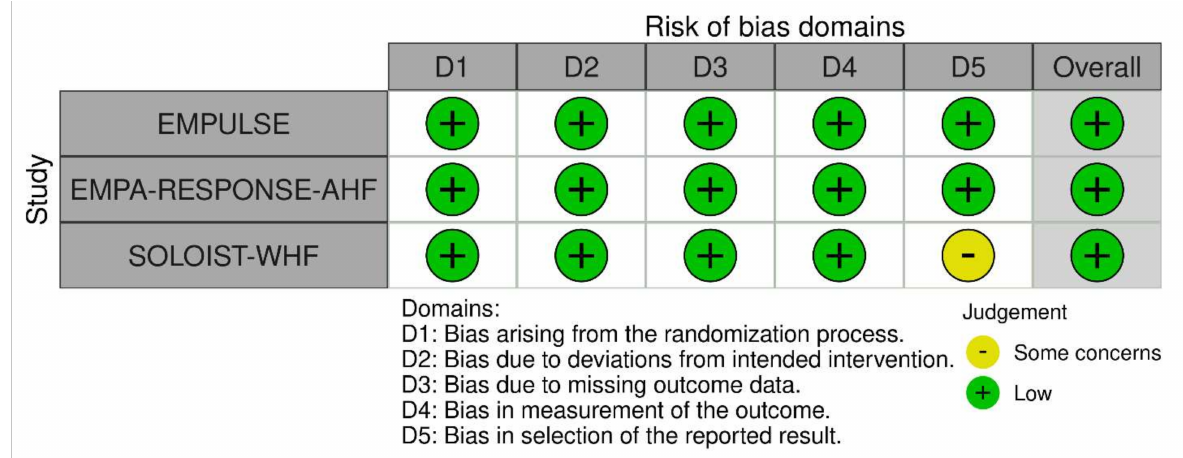
Figure 2. Risk of bias assessment using the Risk of Bias 2.0 tool